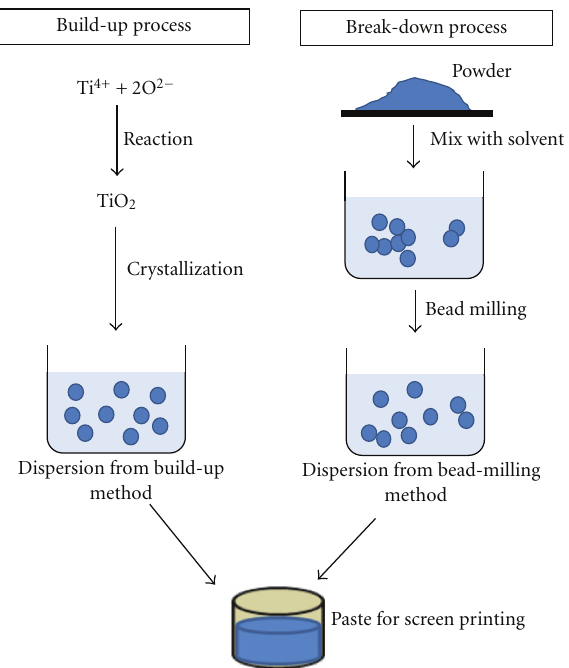
Figure 1: Conventional methods for the preparation of TiO 2